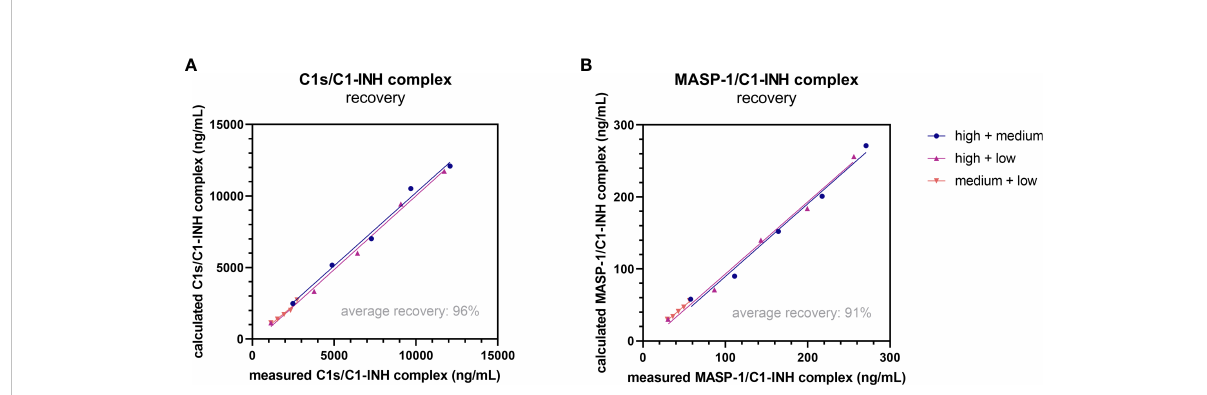
FIGURE 5 Recovery of complexes in EDTA plasma. Recovery of the C1s/C1-INH complex (A) and MASP-1/C1-INH complex (B) was investigated by mixing EDTA plasma samples of three individuals with low, middle and high complex concentration in different ratios (100 + 0, 75 + 25, 50 + 50, 25 + 75, 0 + 100). After 30 min of incubation, C1-INH complex concentrations were determined in the respective assays and recovery (difference between expected and observed C1-INH complex concentration) was calculated according to the equation stated in the Material and Methods section. EDTA, ethylenediaminetetraacetic acid; min,